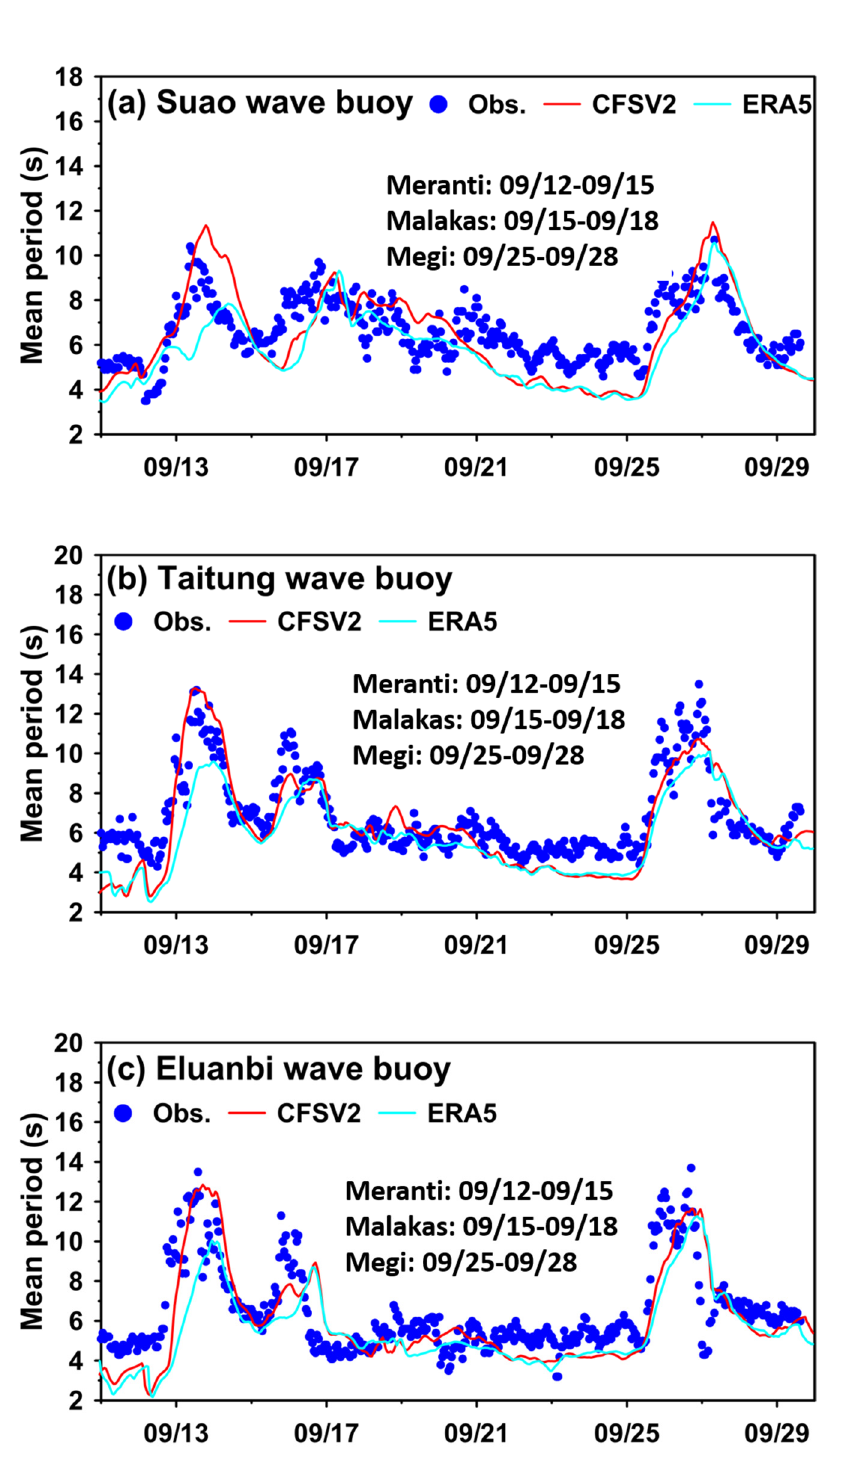
Figure 5. Comparison of the hourly mean period between simulations and measurements for the ( a ) Suao, ( b ) Taitung, and ( c ) Eluanbi wave buoys in September 2016.